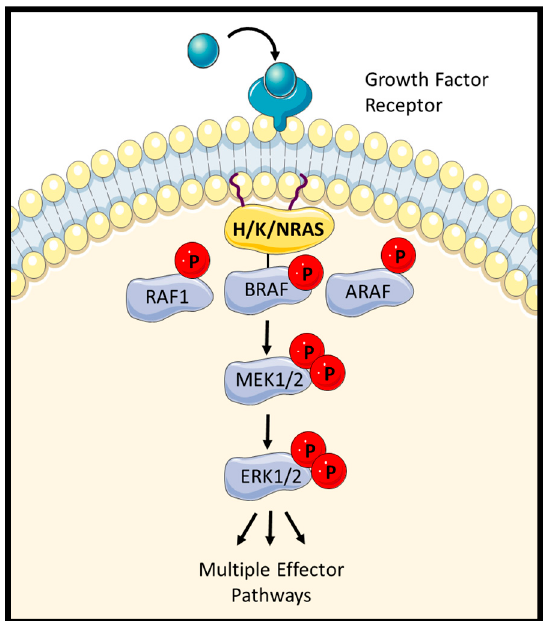
Figure 1. The RAF-MEK-ERK pathway is activated by H/K and NRAS upon extracellular stimuli. ERK1/2 phosphorylate over 50 substrates and control different cell fate. ERK1/2 phosphorylate over 50 substrates and control different cell